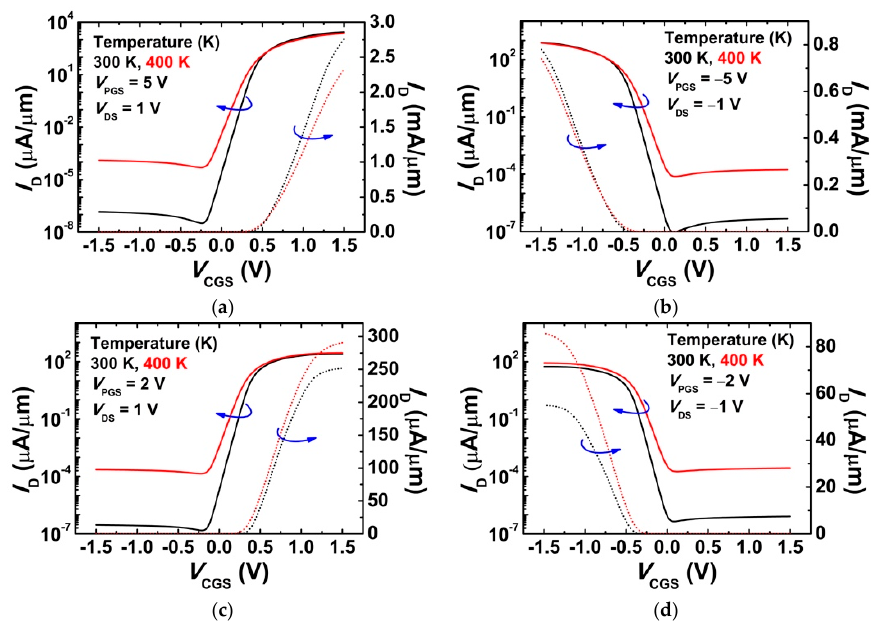
Figure 2. Schematic transfer characteristics depending on T with different V PGS . ( a ) n -FET operations with V PGS = 5 V; ( b ) p -FET operations with V PGS = − 5 V; ( c ) n -FET operations with V PGS = 2 V; ( d ) p -FET operations with V PGS = − 2 V. The arrows indicate the direction of the graph according to log scale and linear scale.